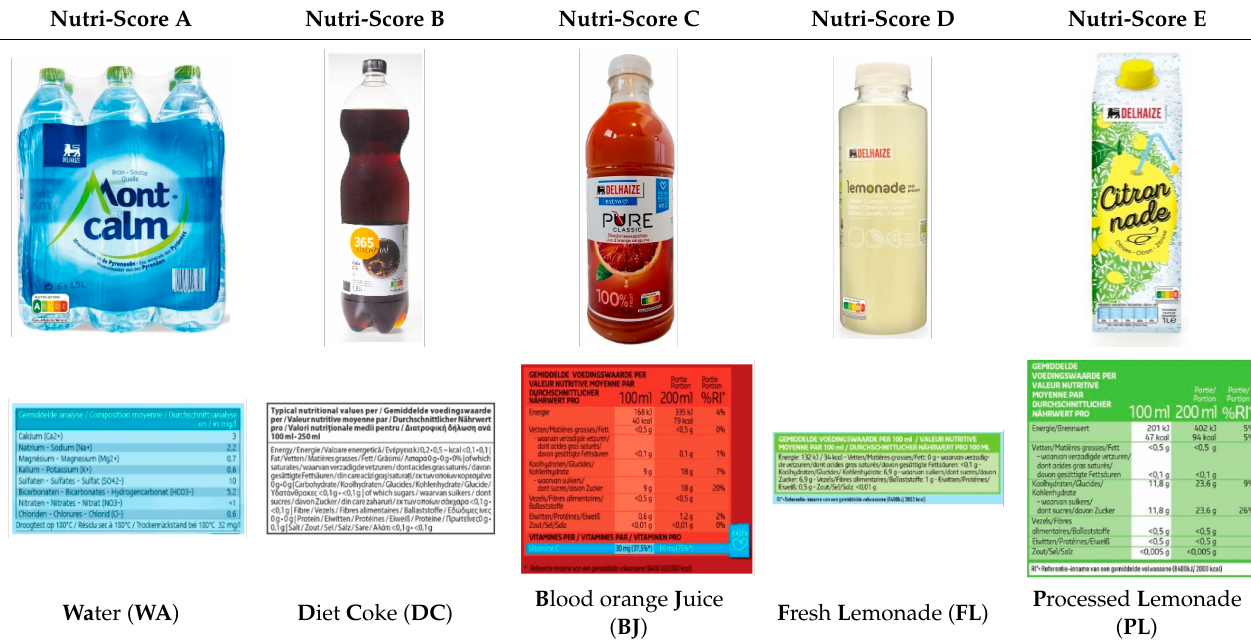
Table A1. Stimuli used in the